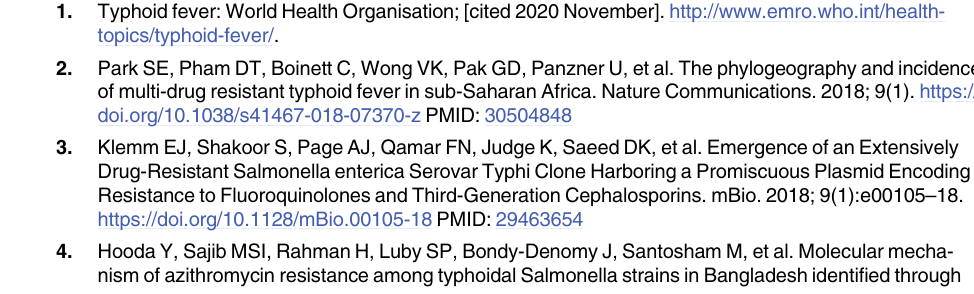
S1 Fig. Gel image showing the results of our singleplex PCR assay using one SNP and multi-SNP S . Typhi XDR Primers on non-XDR DNA samples. Results show that reactions using XDR primers with just the one SNP show amplification on non-XDR DNA samples. However, with the addition of a second SNP at the 3’ end of the primer, no amplification is present in the same non-XDR DNA samples. Lane M, 1kb DNA ladder; lanes 1, 7, 13 and 19 S . Typhi BRD948; lanes 2, 8, 14 and 20; S . Paratyphi A; lanes 3, 9, 15 and 21, S . Paratyphi B; lanes 4, 10, 16 and 22, S . Typhi H58 12148; lanes 5, 11, 17 and 23, S . Typhi H58 12960; lanes 6, 12, 18 and 24, No template control (NTC). S1 Table. Summary of results from testing our multiplex assay on the additional 75 DNA samples plus controls. Samples identified as S . Paratyphi A with our PCR assay are highlighted in green. For these samples the result of subsequent result of whole genome sequencing is also listed. Samples that did not produce any bands are highlighted in